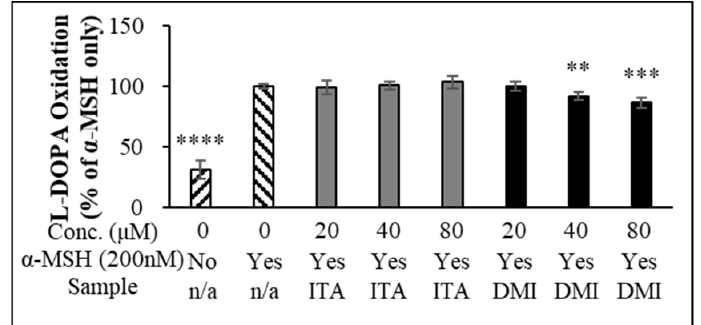
Figure 2. L-DOPA oxidation. The data were presented as the mean ± standard deviation of three independent experiments; ** p < 0.01, *** p < 0.005, **** p < 0.001 compared with α -MSH